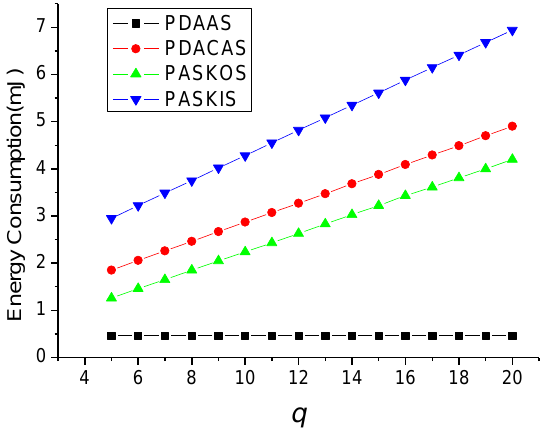
Figure 4. Energy Consumption